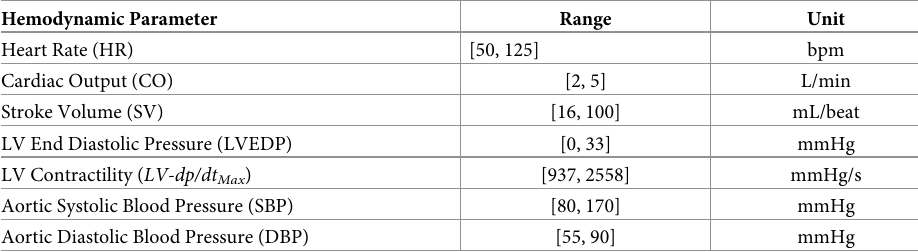
Table 3. Summary of the hemodynamic conditions in the in-vitro experimentations. Hemodynamic Parameter